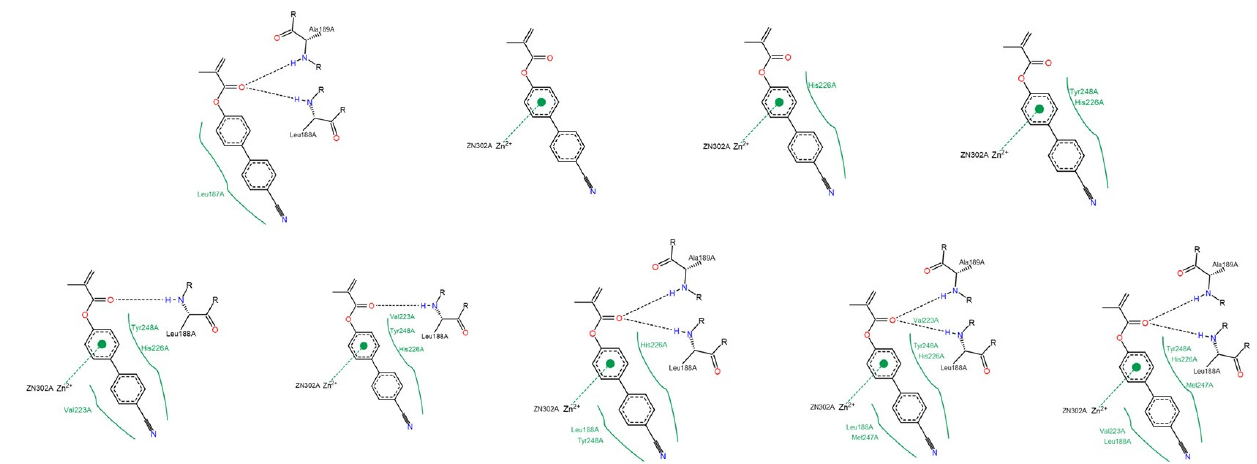
Figure A8. Interactions between compound A and MMP-8, by PoseView calculations.